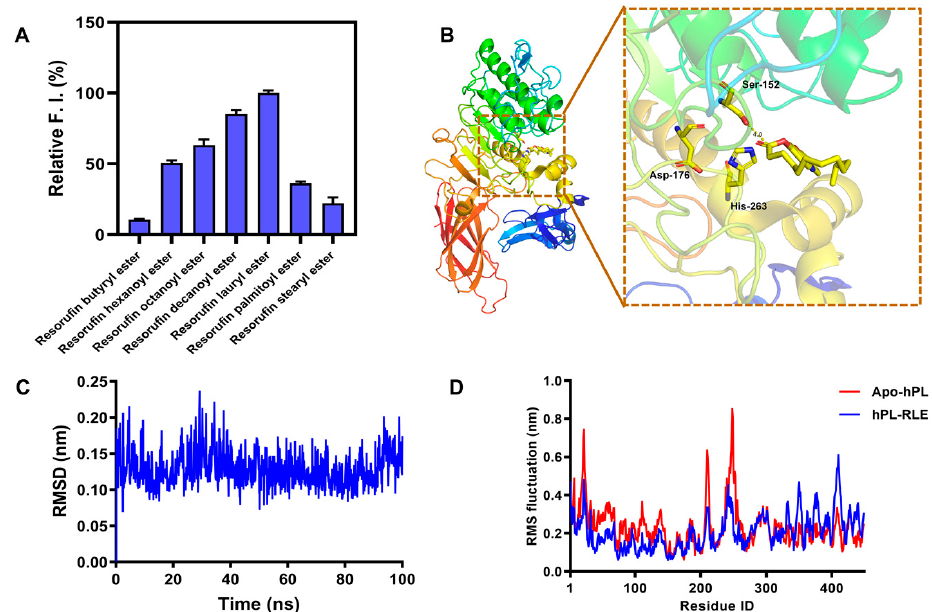
Figure 1. ( A ) Relative fluorescence intensity of each designed substrate (5 µM) towards hPL at 37 °C. ( B ) Docking molecular interaction between hPL and the RLE probe. ( C ) RMSD distribution of RLE on hPL lipase. ( D ) RMSF distribution of residues of hPL lipase and Apo-hPL lipase, as well as hPL binding with RLE. All data are expressed as mean ± SD.